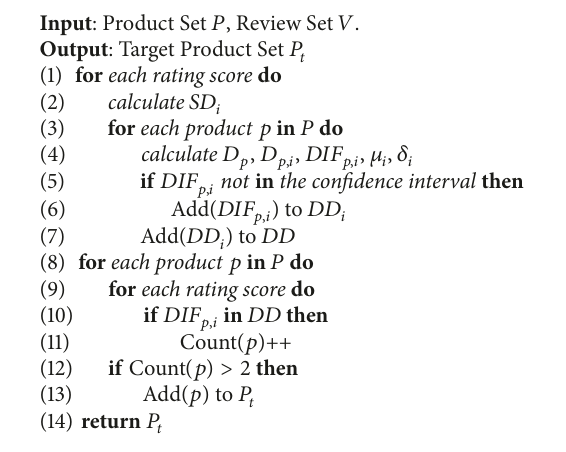
Algorithm 1: StaticTargetProductDetection (𝑃, 𝑉) .